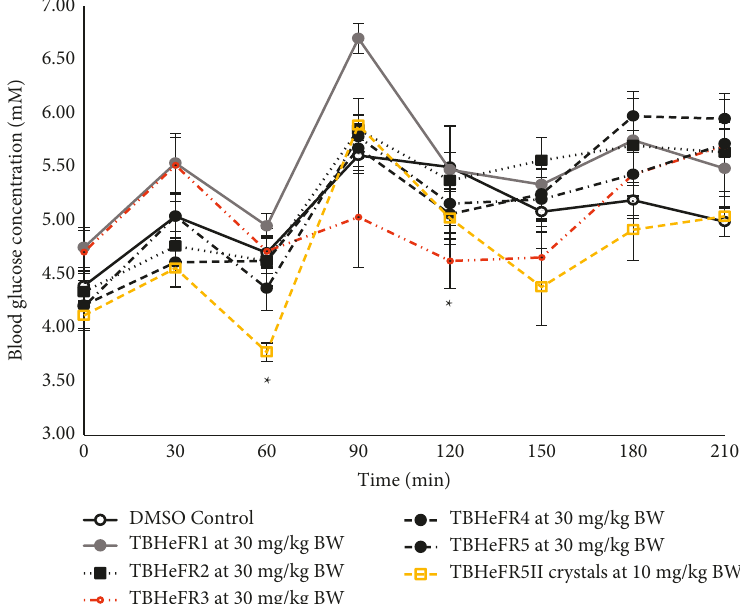
Figure 5: OGTT of semipurified fractions of hexane crude extract when administered intravenously versus DMSO control ( n � 6). ∗ − p < 0 .